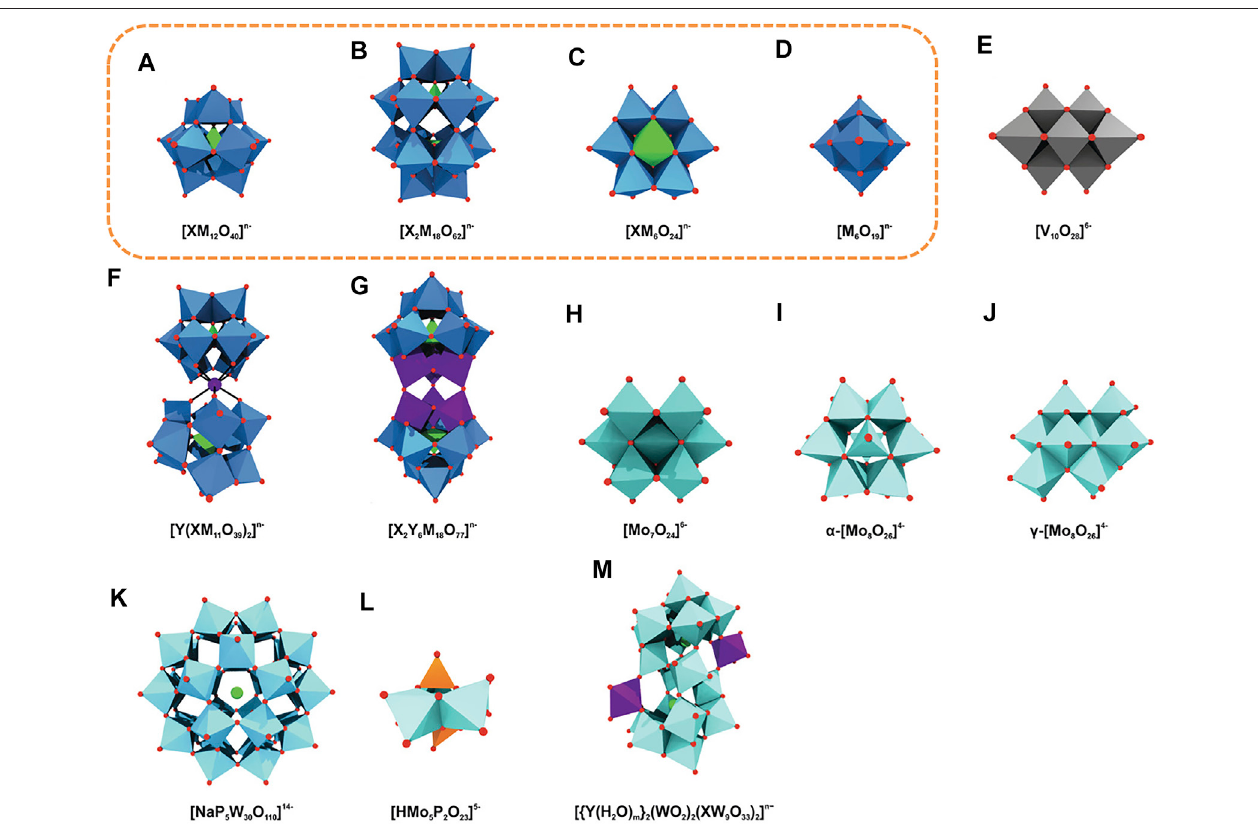
FIGURE 2 | Overview of various archetypal POM anions. (A) Keggin, (B) Wells – Dawson, (C) Anderson, (D) Lindqvist, (E) decavanadate, (F) sandwich Keggin, (G) double Keggin, (H) heptamolybdate, (I) α - and (J) γ -octamolybdate, (K) Preyssler, (L) Strandberg, and (M) Krebs-type structure. Blue polyhedra are {MO 6 } (M = any addenda atom), light green polyhedra {XO n } (X = heteroatom), light green spheres sodium, light blue polyhedra {WO 6 }, light cyan polyhedra {MoO 6 }, gray polyhedra {VO 6 }, purple polyhedra and spheres {YO n } and Y (Y = second heteroatom), orange polyhedra {PO 4 }, red spheres oxygen. The most common polyoxometalates archetypes are highlighted with a yellow box. Adapted from Bijelic et al.